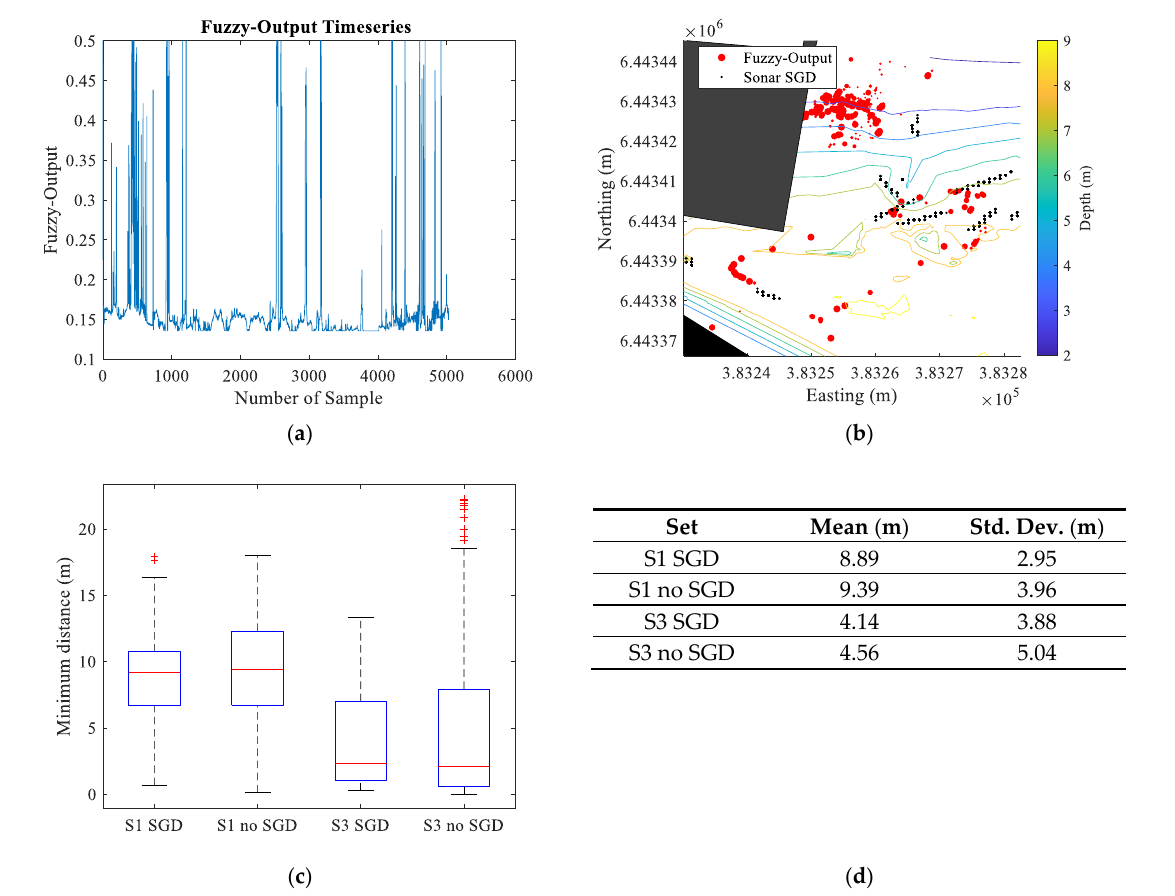
Figure 15. ( a ) Fuzzy output time series for all three ROV surveys; ( b ) spatial distribution of high fuzzy outputs (marker size is proportional to output value) and the identified potential SGD plumes; ( c ) boxplot of the minimum distance between the in situ data separated by surveys and fuzzy output and the SGD plumes locations identified by sonar; ( d ) mean value and standard deviation of the four subsets of in situ data.